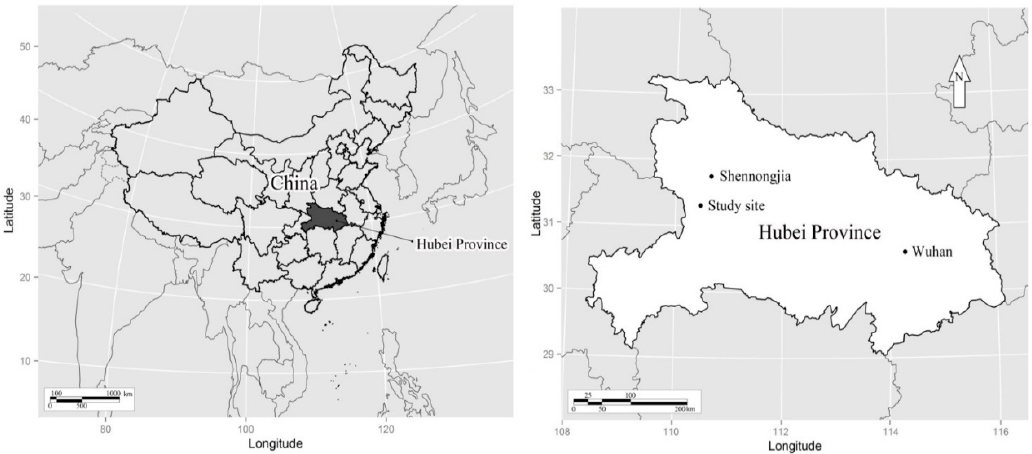
Figure 1. Location of the study site.